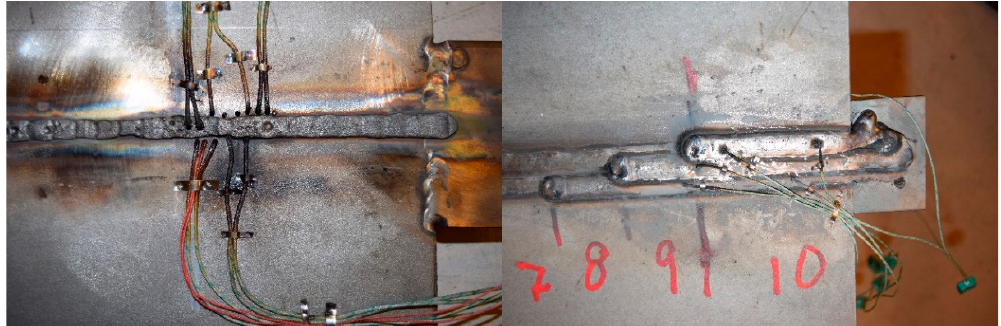
Figure 4. ( Left ) Back side of the joint showing the layout of the thermocouples inserted through drilled holes. ( Right ) Front side of the joint showing the layout of the harpooned thermocouples in the last passes. Note that the image shows the harpooned thermocouples only in the last passes because most of them have to be removed prior to welding of the following weld pass.